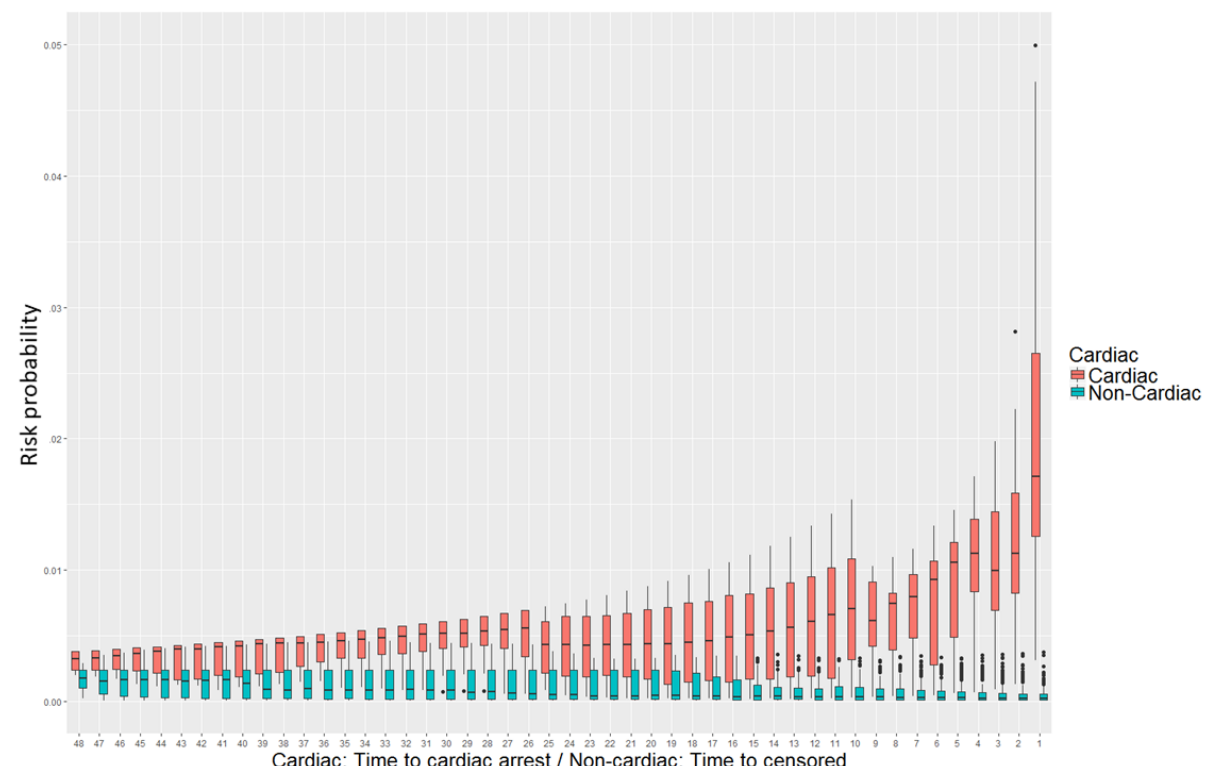
Figure 5. Risk probability comparison between cardiac arrest and the non–cardiac arrest groups. The x-axis represents the time point, and the y-axis represents the distribution of probability density values for cardiac arrest obtained for each patient corresponding to each time point.